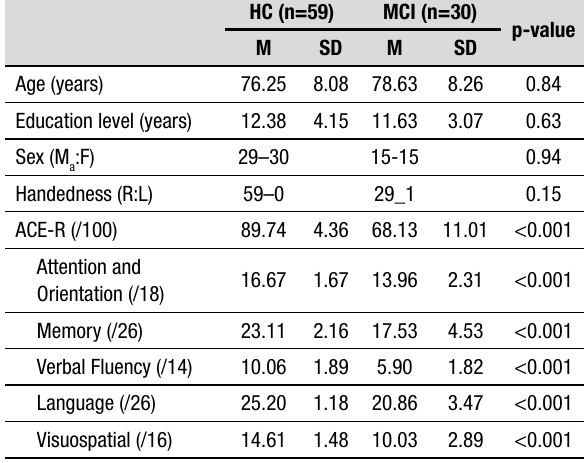
Table 1. Demographic and neuropsychological characteristics of Healthy Controls and Mild Cognitive Impairment patients.